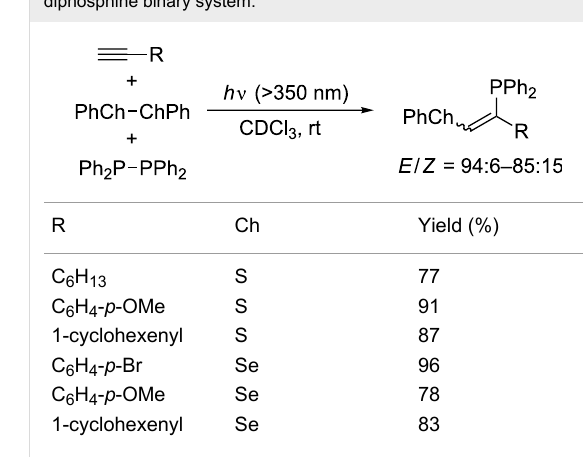
Table 5: Photoinduced thio- and selenophosphination by dichalcogen/ diphosphine binary